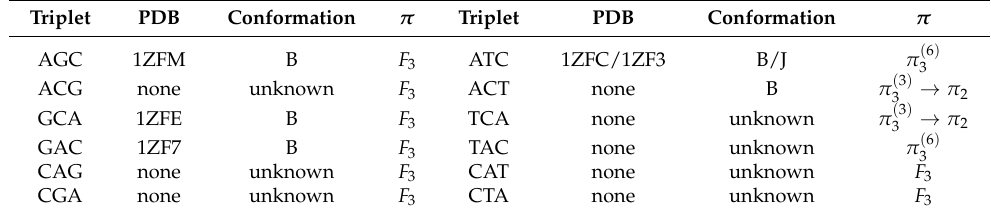
Table 8. Group analysis of the sequence d ( CCnnnN 6 N 7 N 8 GG ) [10], where N 6 , N 7 and N 8 are taken in the three nucleotides A ,G, C (left) and A, T, C (right). The card seq for π [ 1,7,59,874,20371,748320 · · ·